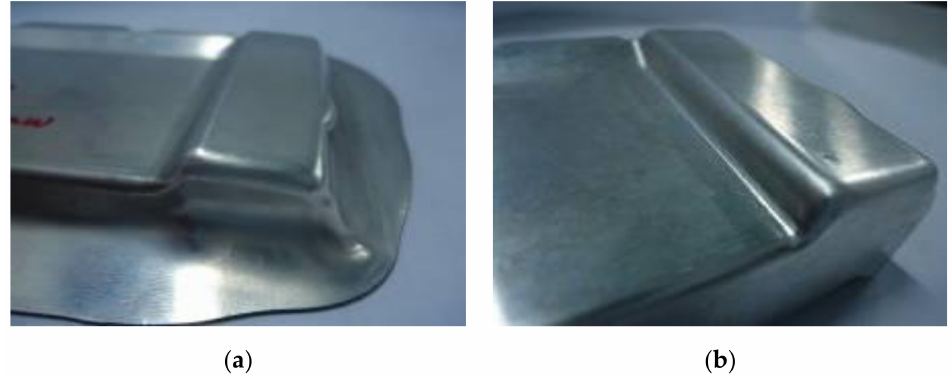
Figure 19. The experimental forming results for Case II. ( a ) The first stage; ( b ) the second